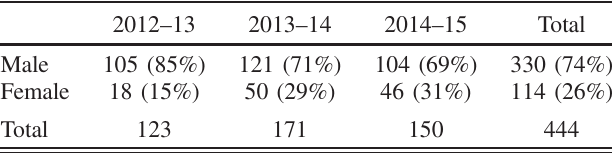
TABLE III. Gender split of 2012 – 13 through 2014 – 15 cohorts.